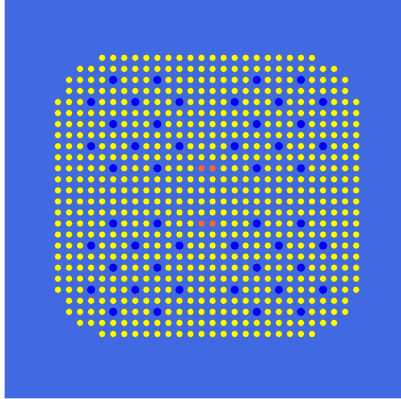
Figure 3: LEU-COMP-THERM-054 Case 01